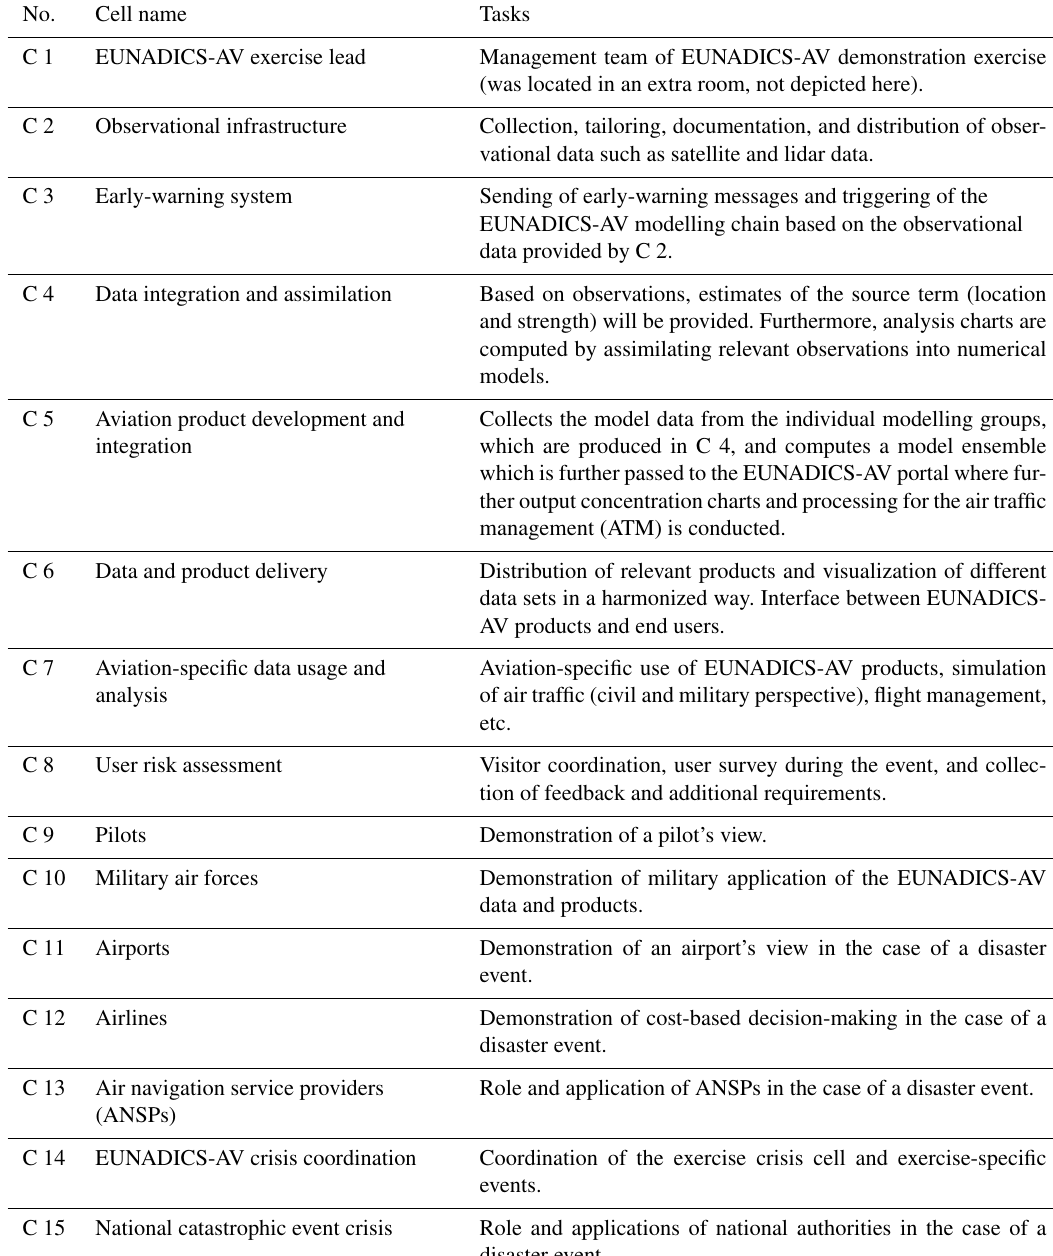
Table 1. EUNADICS-AV demonstration exercise cells and related